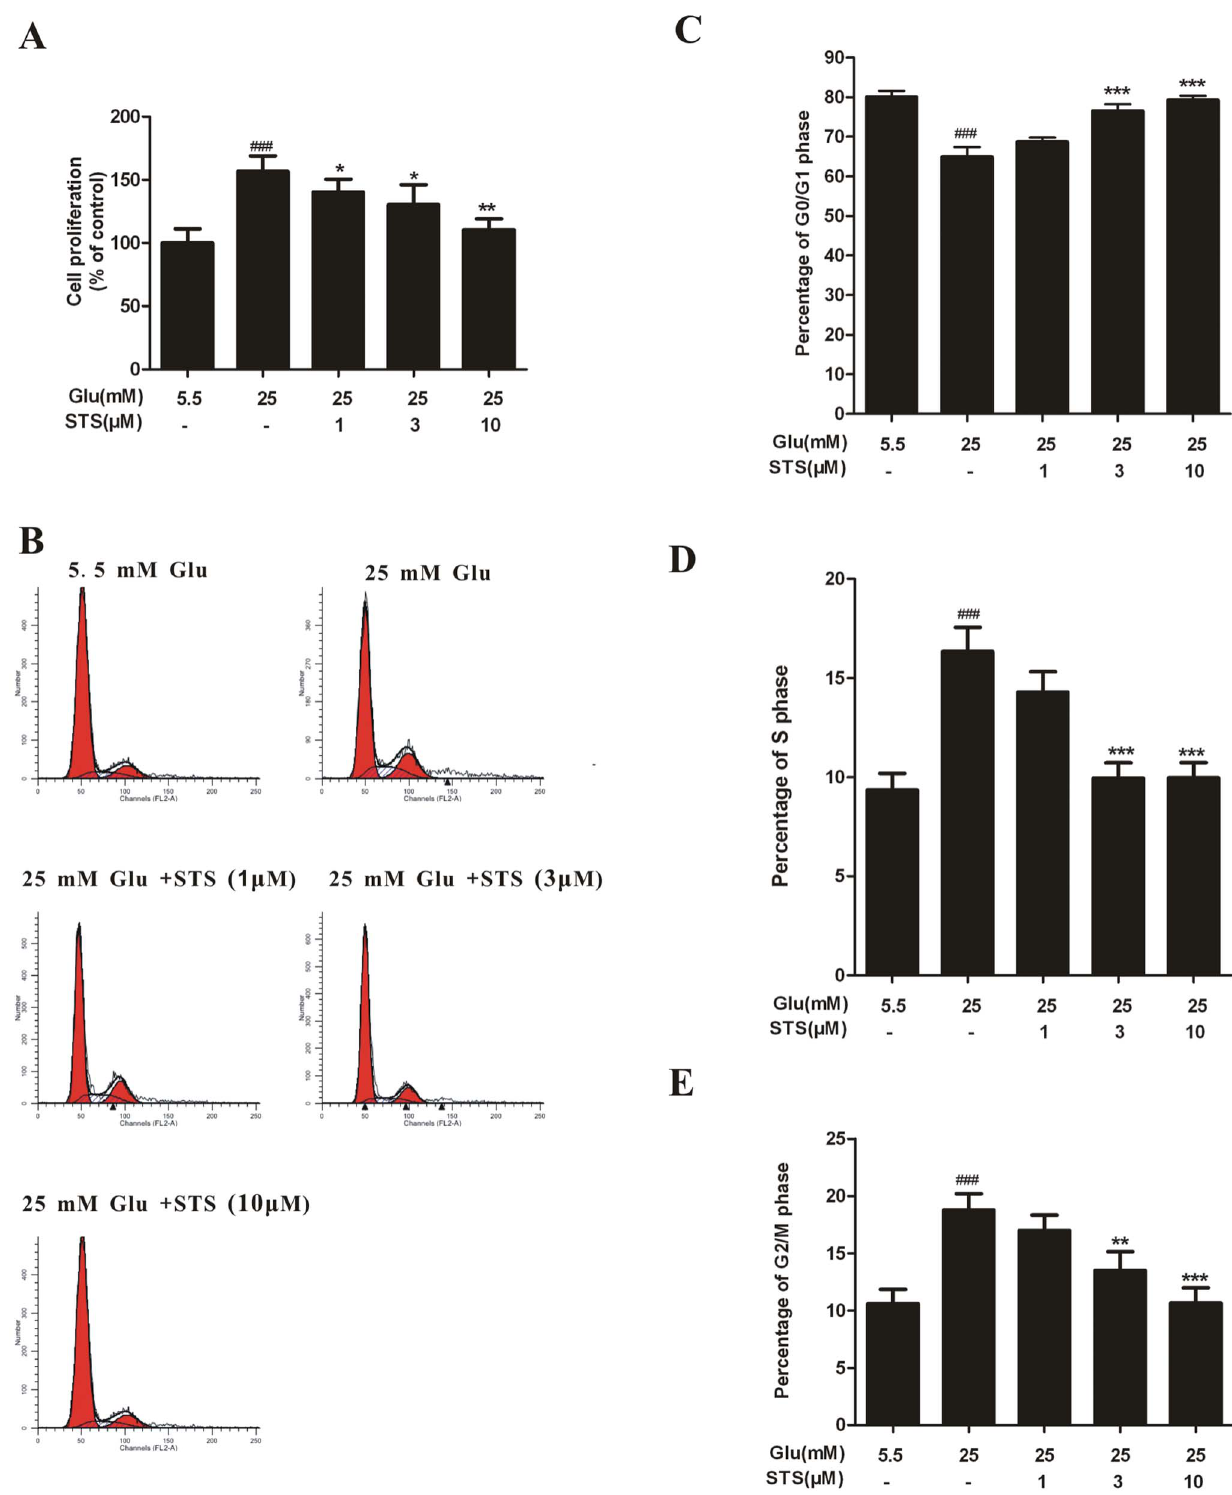
Figure 2. Effects of STS on cell proliferation and cell cycle distribution. (A) STS inhibits HG-induced VSMC proliferation. VSMCs were treated with different concentration of STS for 2 h before exposed to HG for 48 h. Cell proliferation was evaluated with the MTT assay. Relative proliferation activities were expressed using untreated control cells as a standard. Values are presented as mean values 6 SD. ### p , 0.001 vs control. * p , 0.05, ** p , 0.01 vs HG group. (B) VSMC counts in the G 0 /G 1 , S, and G 2 /M phases are shown for normal, high glucose, and different doses of STS. Quantitative assessment of the percentage of VSMCs at G 0 /G 1 , S, and G 2 /M phases is shown (C–E). G 0 /G 1 phase is represented by the first peak, S phase in diagonal and and G 2 /M phase by the second peak. Cell counts were increased in the G 0 /G 1 phase and deceased in S and G 2 /M phases, compared with the high glucose group, indicating that STS induces cell cycle arrest at the G 0 /G 1 phase in a dose-dependent manner. Values are presented as means 6 SD. ### p , 0.01 vs control. ** p , 0.01, *** p , 0.01 vs HG group. doi:10.1371/journal.pone.0094957.g002 PLOS ONE |